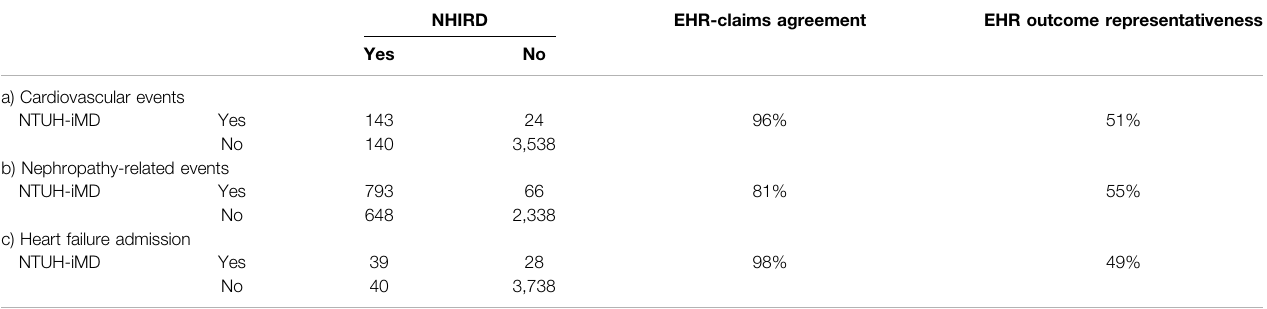
TABLE 2 | Outcomes captured in the Integrated Medical Database of National Taiwan University Hospital (NTUH-iMD) compared to the linked National Health Insurance Research Database (NHIRD) among oral hypoglycemic agent users with continuous 6-month baseline and 24-month follow-up data ( n =